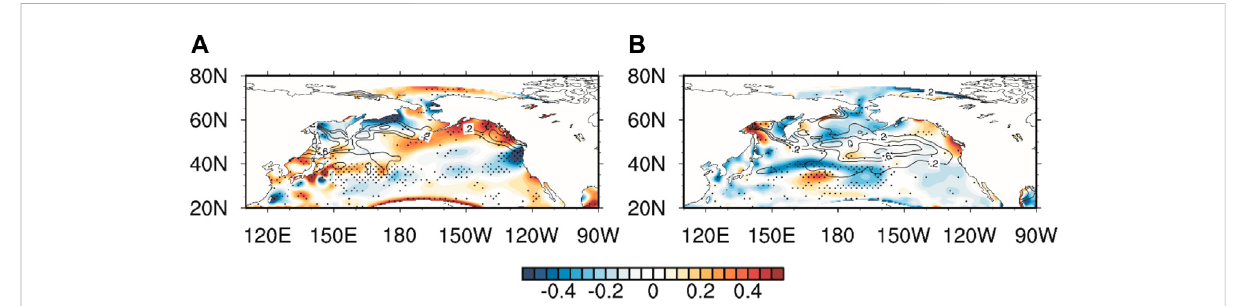
Response of air temperature advection at 850 hPa to different scales of KE-related SSTAs (shading, unit: 10 – 3 K s − 1 ), where the isoline is the corresponding atmospheric baroclinicity at 850 hPa (isoline, unit: 10 − 6 s − 1 ), showing only the positive value. (A) Response of temperature advection and atmospheric baroclinicity to mesoscale SSTAs; (B) response of temperature advection and atmospheric baroclinicity to large-scale SSTAs. Statistically signi fi cant differences at 90% according to Student ’ s t test are